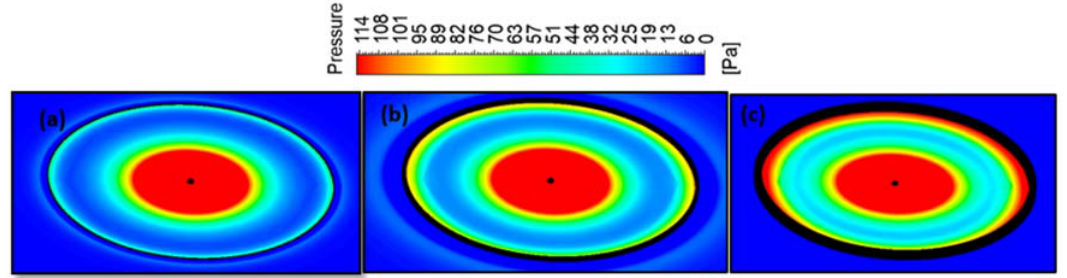
Figure 13. Pressure contours for R/D = 2, for three rib heights, ( a ) 0.25 mm, ( b ) 0.75 mm, and ( c ) 1.5 mm.